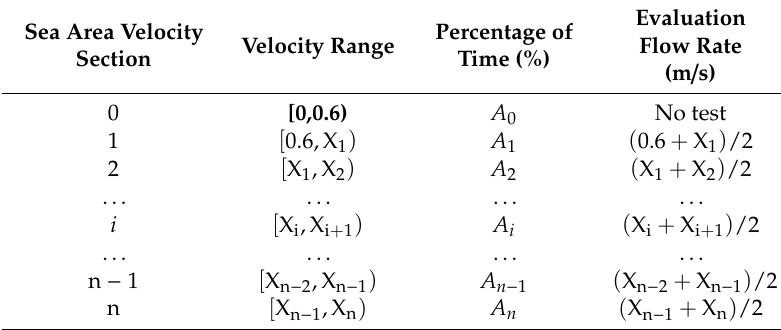
Table 2. Statistical segmentation results of sea area flow